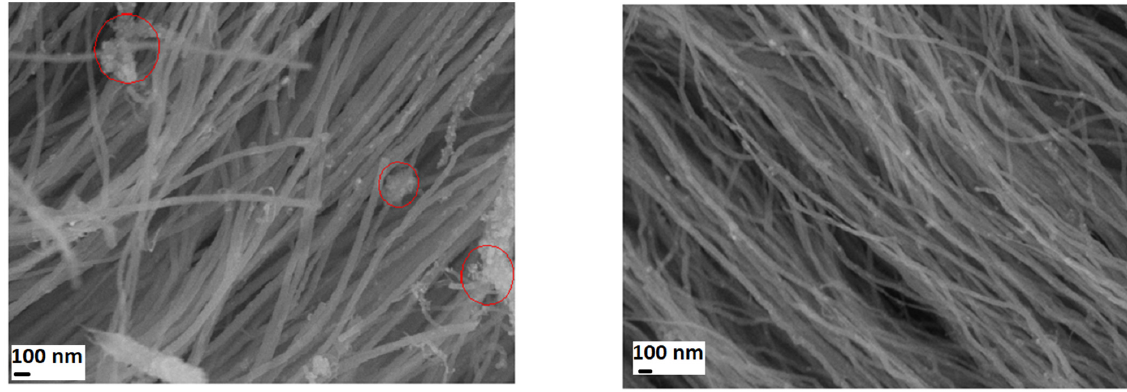
Figure 3. SEM images of pristine ( left ) and functionalized ( right ) MWCNTs.